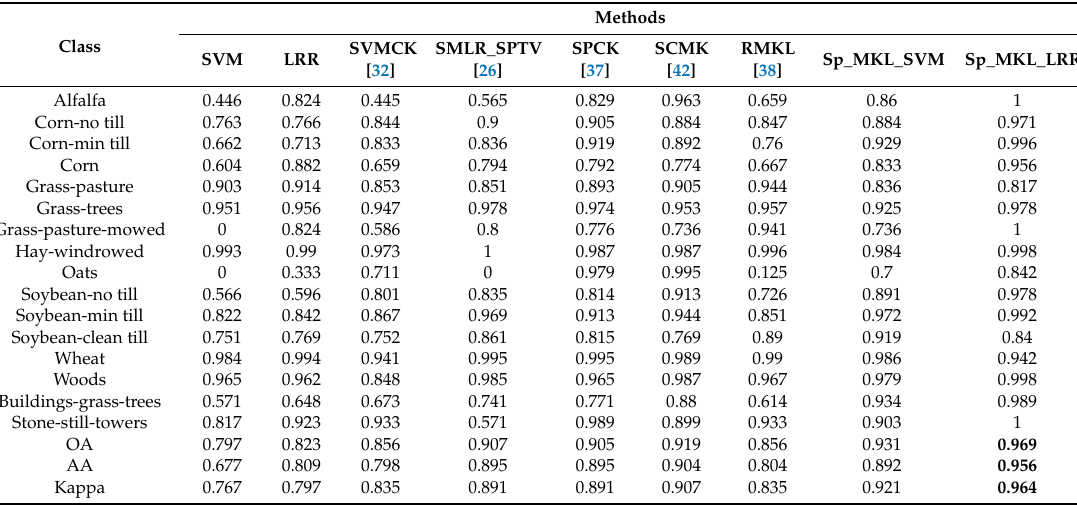
Table 1. The classification results on Indian Pines